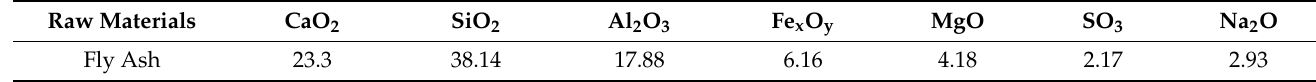
Table 2. Chemical composition of fly ash type C (provided by material supplier).